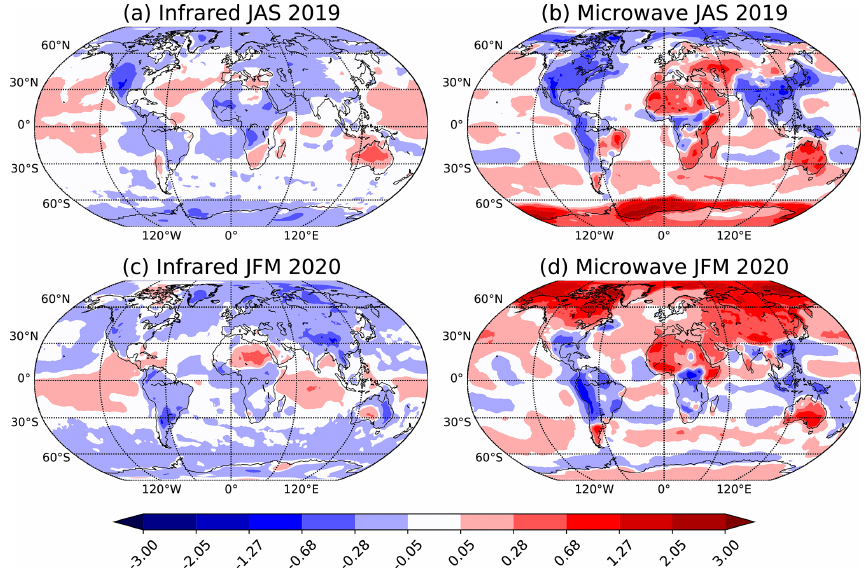
Figure 1. Time average of the skin temperature increment (in K) from the SKTECV experiment for (a, b) JAS 2019 and (c, d) JFM 2020 for (a, c) the infrared field and (b, d) the microwave field.